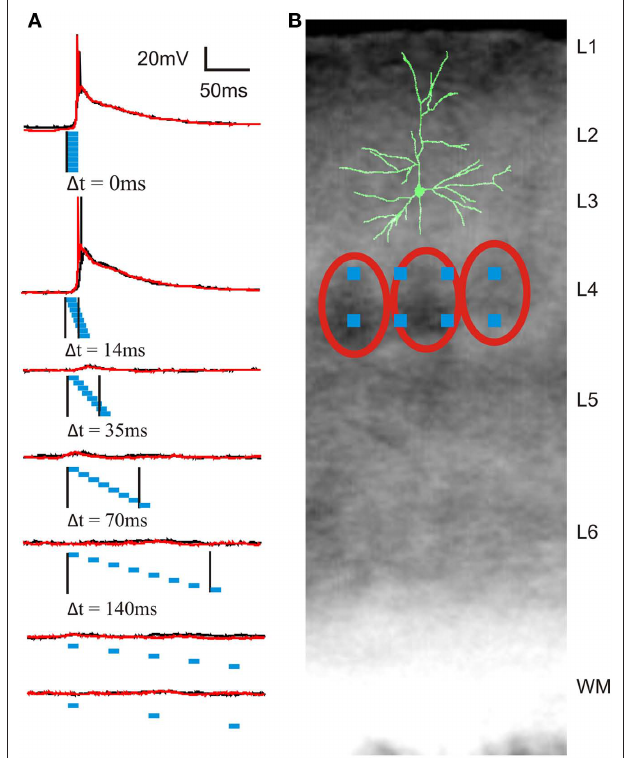
Figure 4 | example of layer 2/3 pyramidal cell membrane potential responses to photostimulation of eight sites in layer 4 with different degrees of synchrony. (A) Membrane potential responses (two trials shown as red and black traces) to photostimulation with seven different degrees of synchrony. Blue rectangles represent timing and duration of eight photostimuli. Black vertical lines mark the times of onset of the first and last photostimulus, corresponding to the time window or temporal precision of synchronization ( ∆ t = 0 to 350 ms). Duration of each individual photostimulus was 10 ms. (B) Location of photostimulation sites in a coronal barrel cortex slice with overlay of a partially reconstructed biocytin-filled cell. Red ovals outline cell-dense